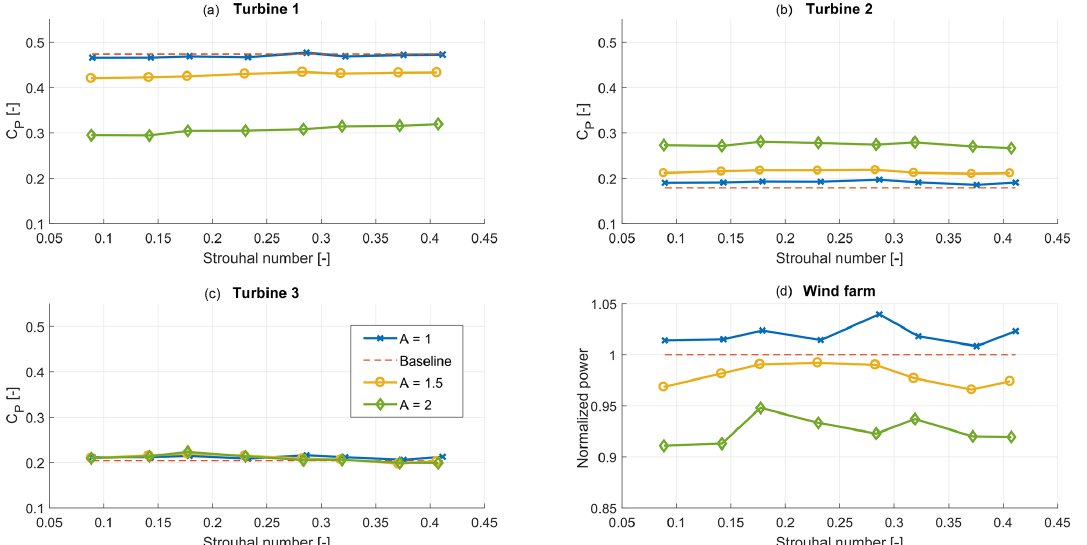
, as defined in Table 2, in the high-TI case. Panel ( d ) shows the total power Figure 13. C P of the wind farm for different amplitudes A of C (cid:48) T conversion compared to the baseline case. Table 5. An overview of the total power increase by applying dynamic induction control with different amplitudes ( A , rows) and frequencies (columns) for the high-TI case. The values in bold indicate the optimal frequency at each specific amplitude of excitation. Frequency (Hz)